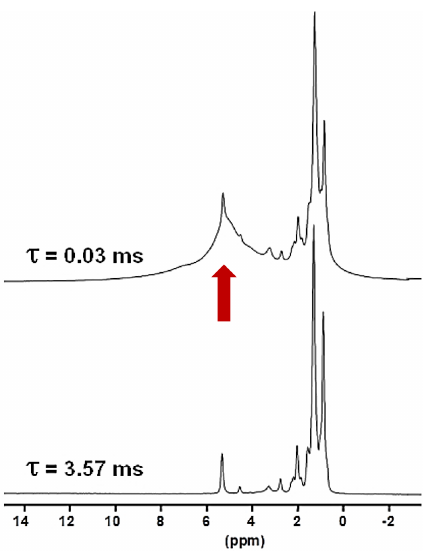
Figure 4. 1 H Hahn echo MAS NMR spectra for KS3 recorded at 16.4T. τ was synchronized with the rotation frequency, which is shown here as ν rot = 30kHz. No temperature control was im- plemented, leading to a ∼ 40 ◦ C increase in the sample tempera- ture and the associated increase in local dynamics. The vertical red arrow corresponds to the resonance coming from COM (see also Fig. 1a and